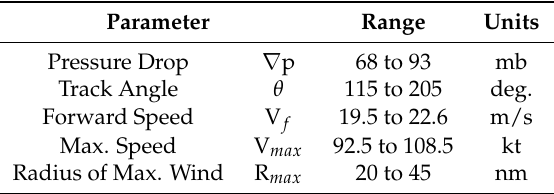
Table 3. Range of PMH